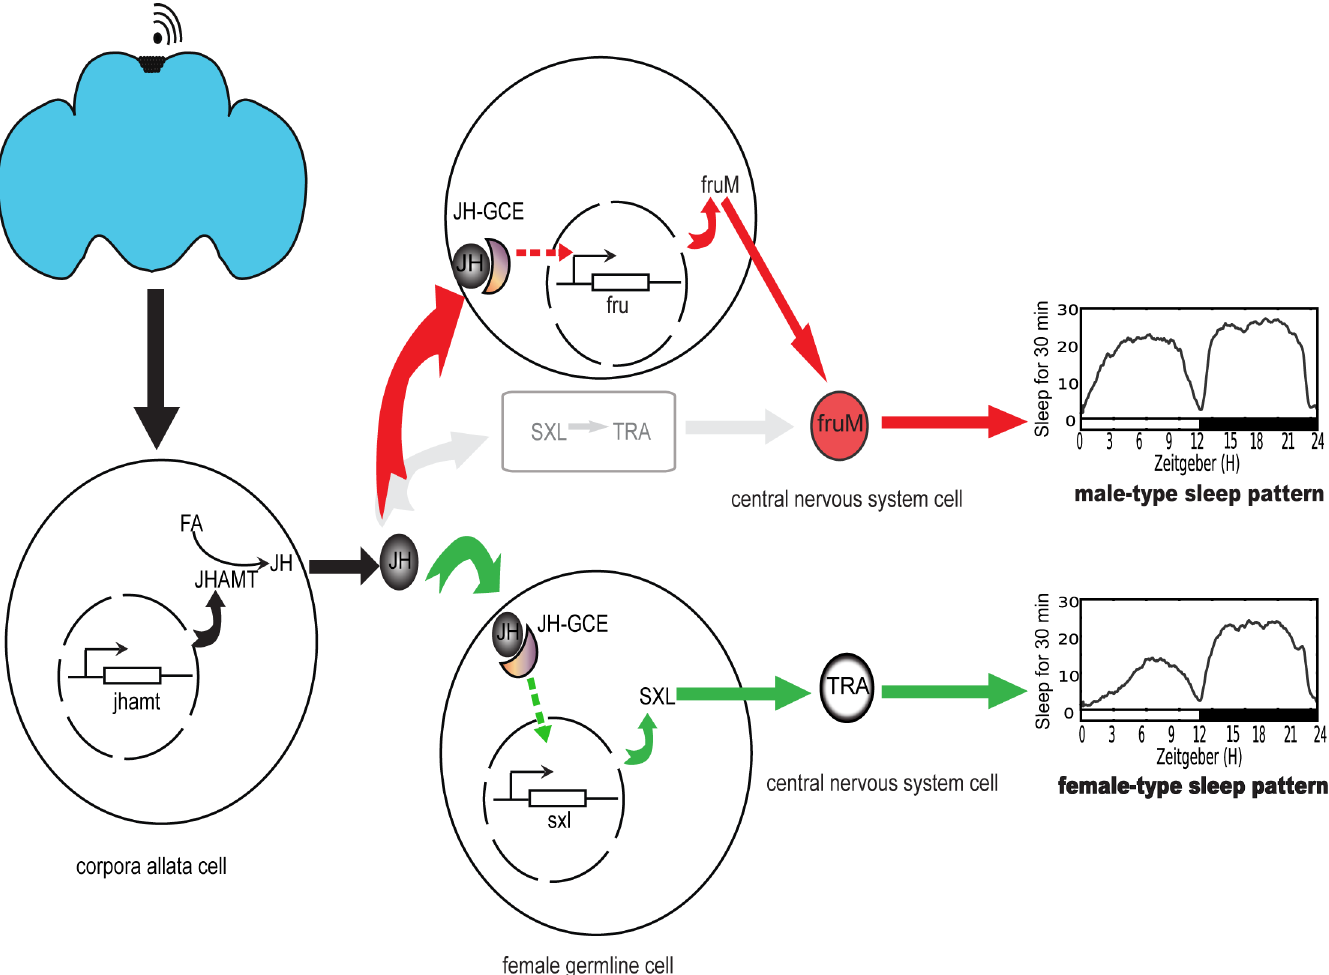
Fig 8. Model of JH-GCE signals regulating sexually dimorphic sleepJH signals from Drosophila brain (PI possibly) target sex differentiation-related genes and sustain male- and female-sleep types. The black arrow represents JH signals, while the red and green arrows represent JH/GCE-FRU and JH/GCE-SXL-TRA pathways,